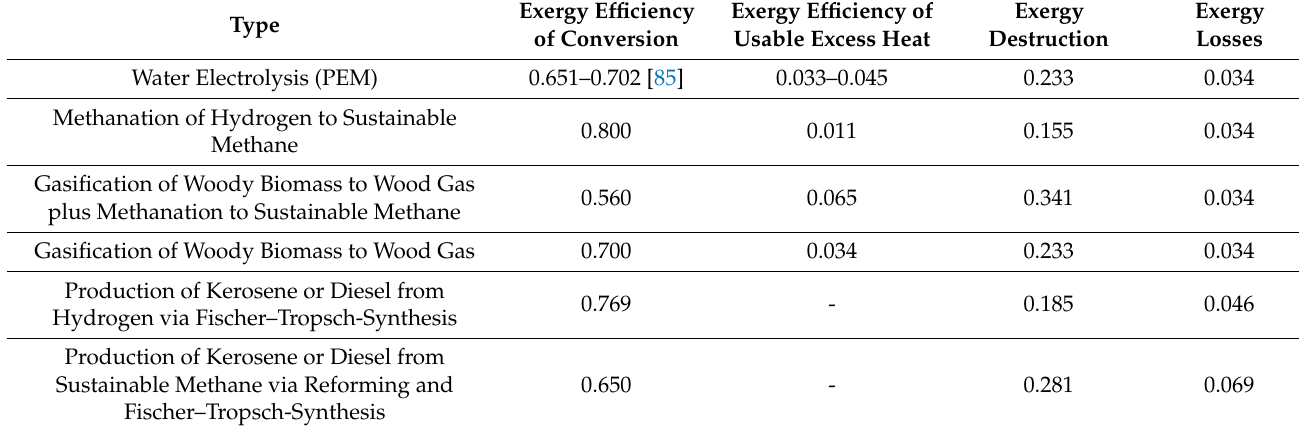
Table A3. Available conversion units of the scenario Energy Efficiency [47].